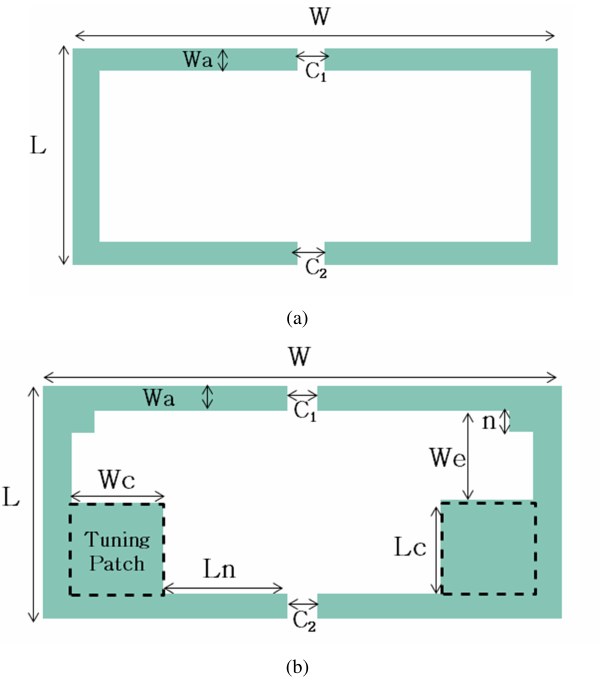
FIGURE 1: Configuration of the RFID tag antenna a) before adding parasitic elements b) last prototypes.